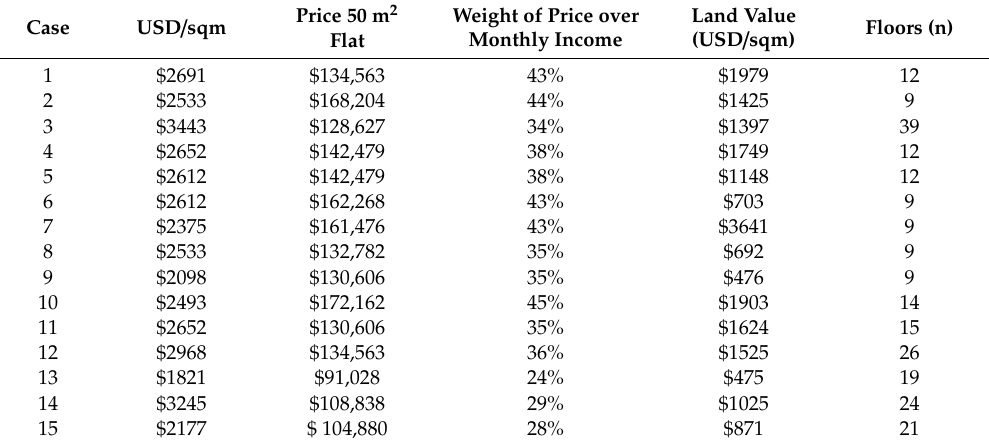
Table3. Generaldescriptionofcasesanalysed. Source: